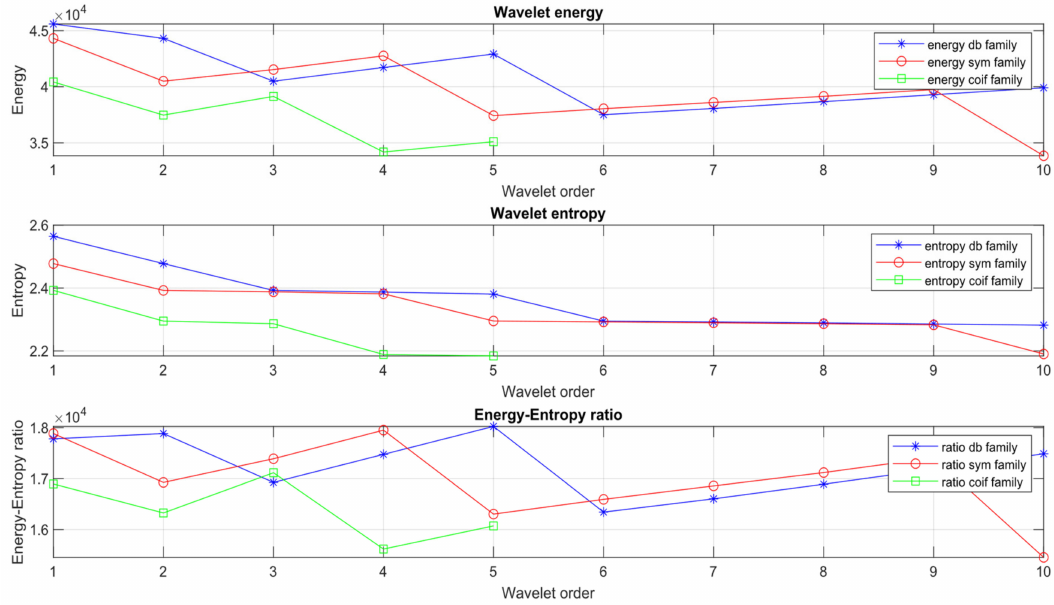
Figure 6. Mother wavelet selection—quantitative